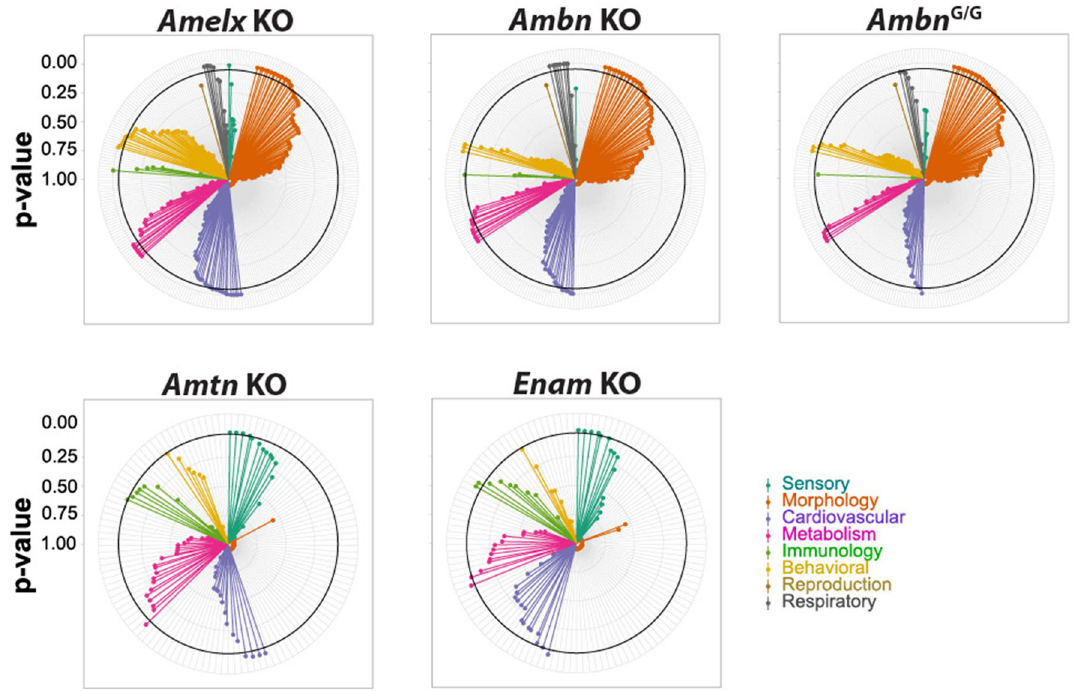
Figure 3. Functional pleiotropy of EMPs revealed by unbiased phenotyping. Circular graphs visualizing significant difference of mouse mutants from WT baseline divided to 8 groups phenotypes: sensory (e.g. hearing or eye retina morphology—in blue-green), morphology (skeletal morphology and bone mineralization—in orange), cardiovascular (e.g. blood pressure, cardiography—in violet), metabolism (e.g. body mass, lean/fat ratio, glucose tolerance—in magenta), immunology (T-cells and B-cells populations characterization—in green), behavioral (e.g. grip strength, dark/light box test, hot/cold plate test—in yellow), reproduction (i.e. number of litters—in brown), and respiratory (e.g. capacity and elasticity of lungs—in gray). Each radius is one variable. Thick black circle marks the level of significance = 0.05—points outside the circle are significant results.